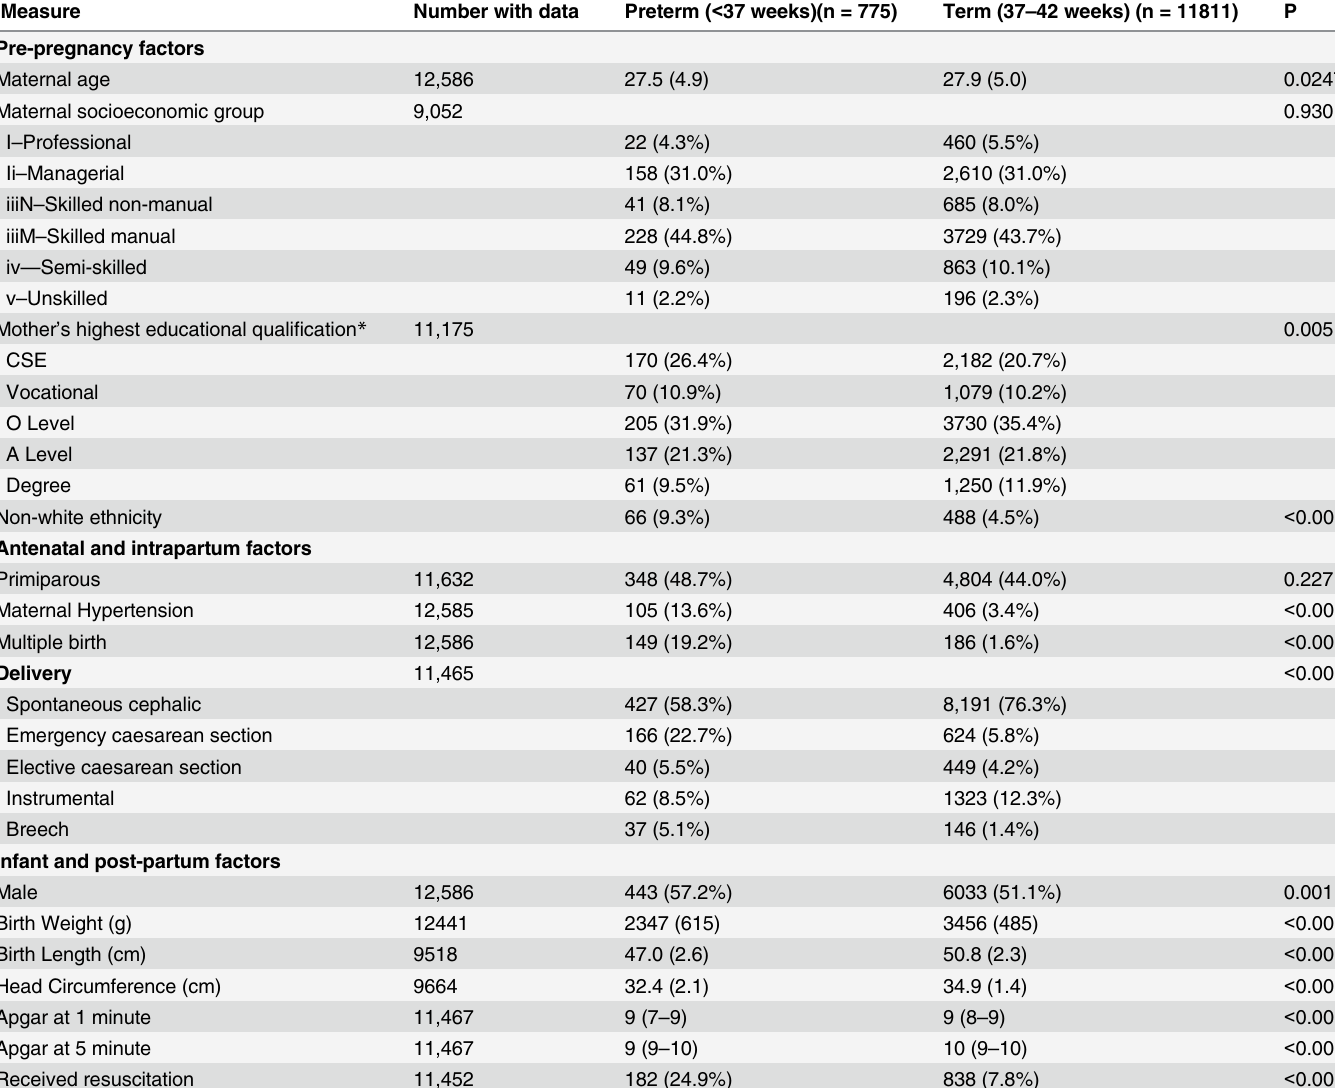
Table 1. Characteristics of study